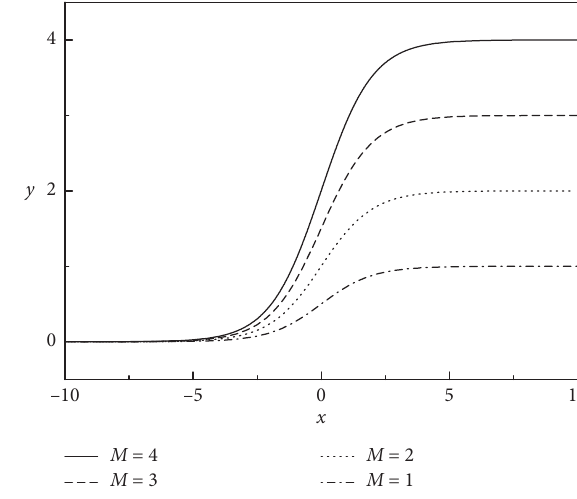
Figure 8: Comparison of different M value function